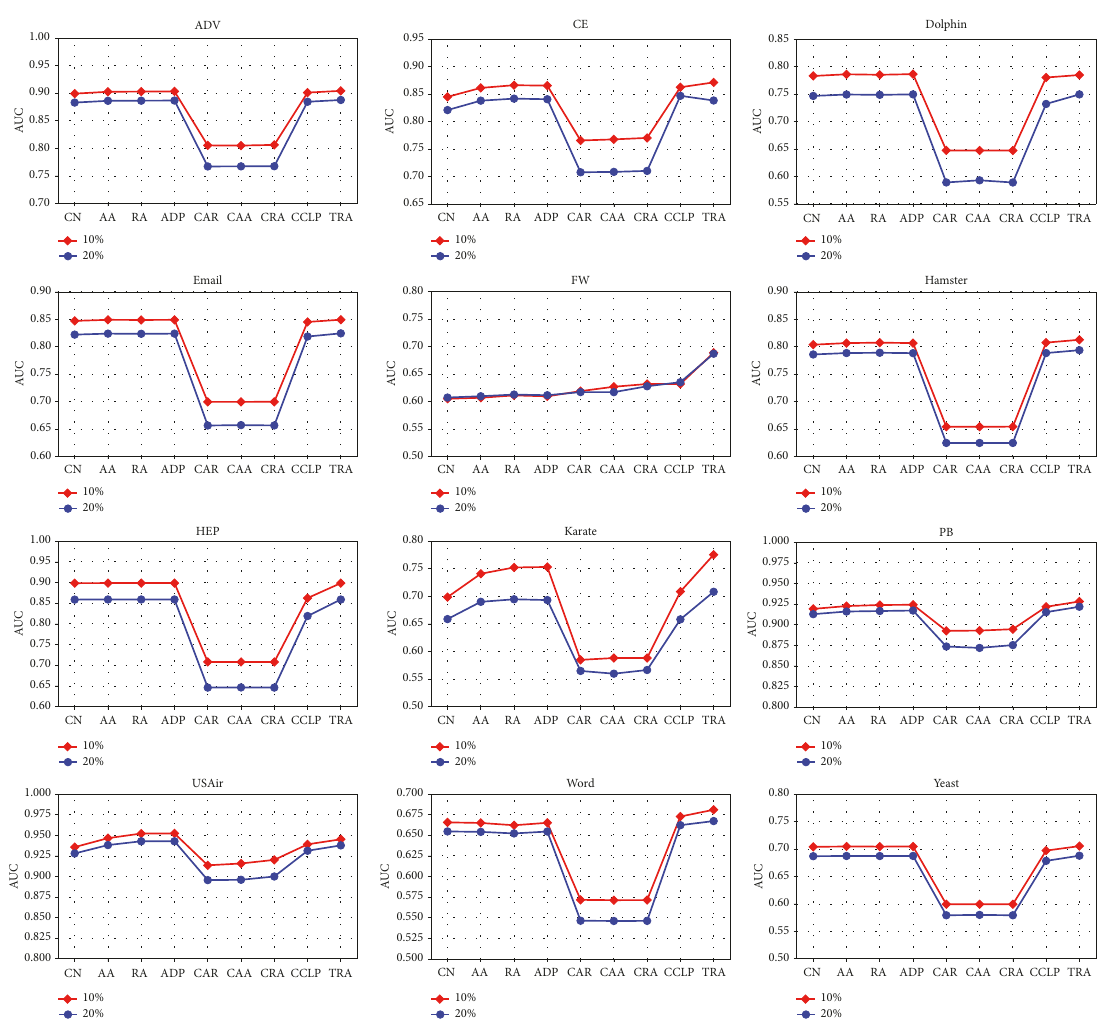
Figure 3: The changes of AUC when |𝐸 𝑡𝑠 |/|𝐸| increases from 10% to 20% on 12 networks. Each point is obtained by averaging over 50 independent